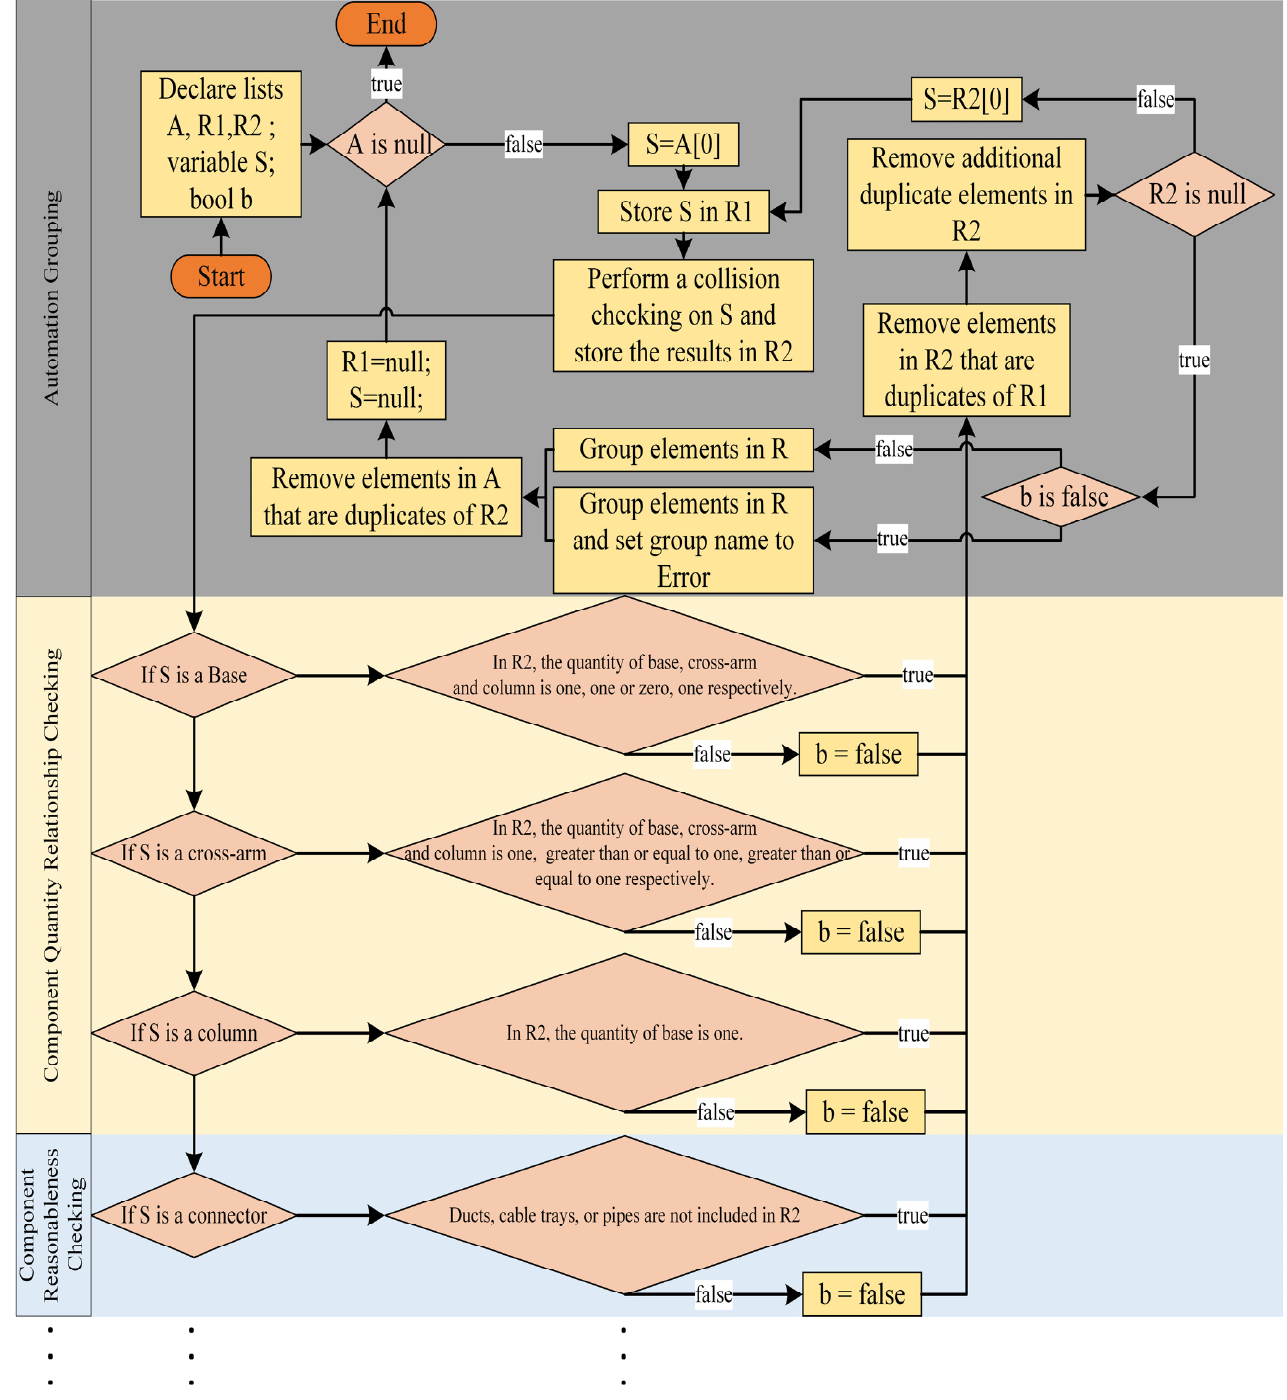
Figure 10. Algorithm for Automatic Grouping and Component Relationship Checking .